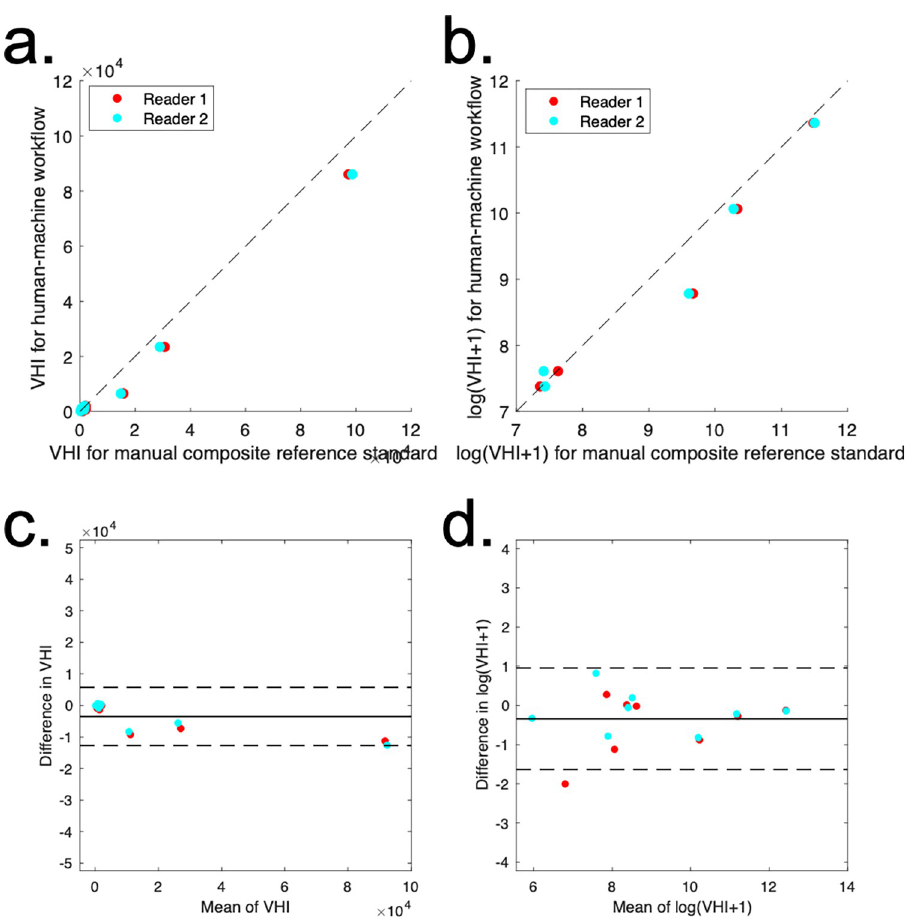
Fig 5. Accuracy of human-machine workflow against a composite manual reference standard formed from all four human segmentations (two from each reader). In the scatterplots (top row), the dotted line represents unity. In the Bland-Altman plots (bottom row) the mean bias (solid line) and 95% limits of agreement (dashed lines) are shown. Both plots show only a small bias and good precision relative to the range of V HI values present.